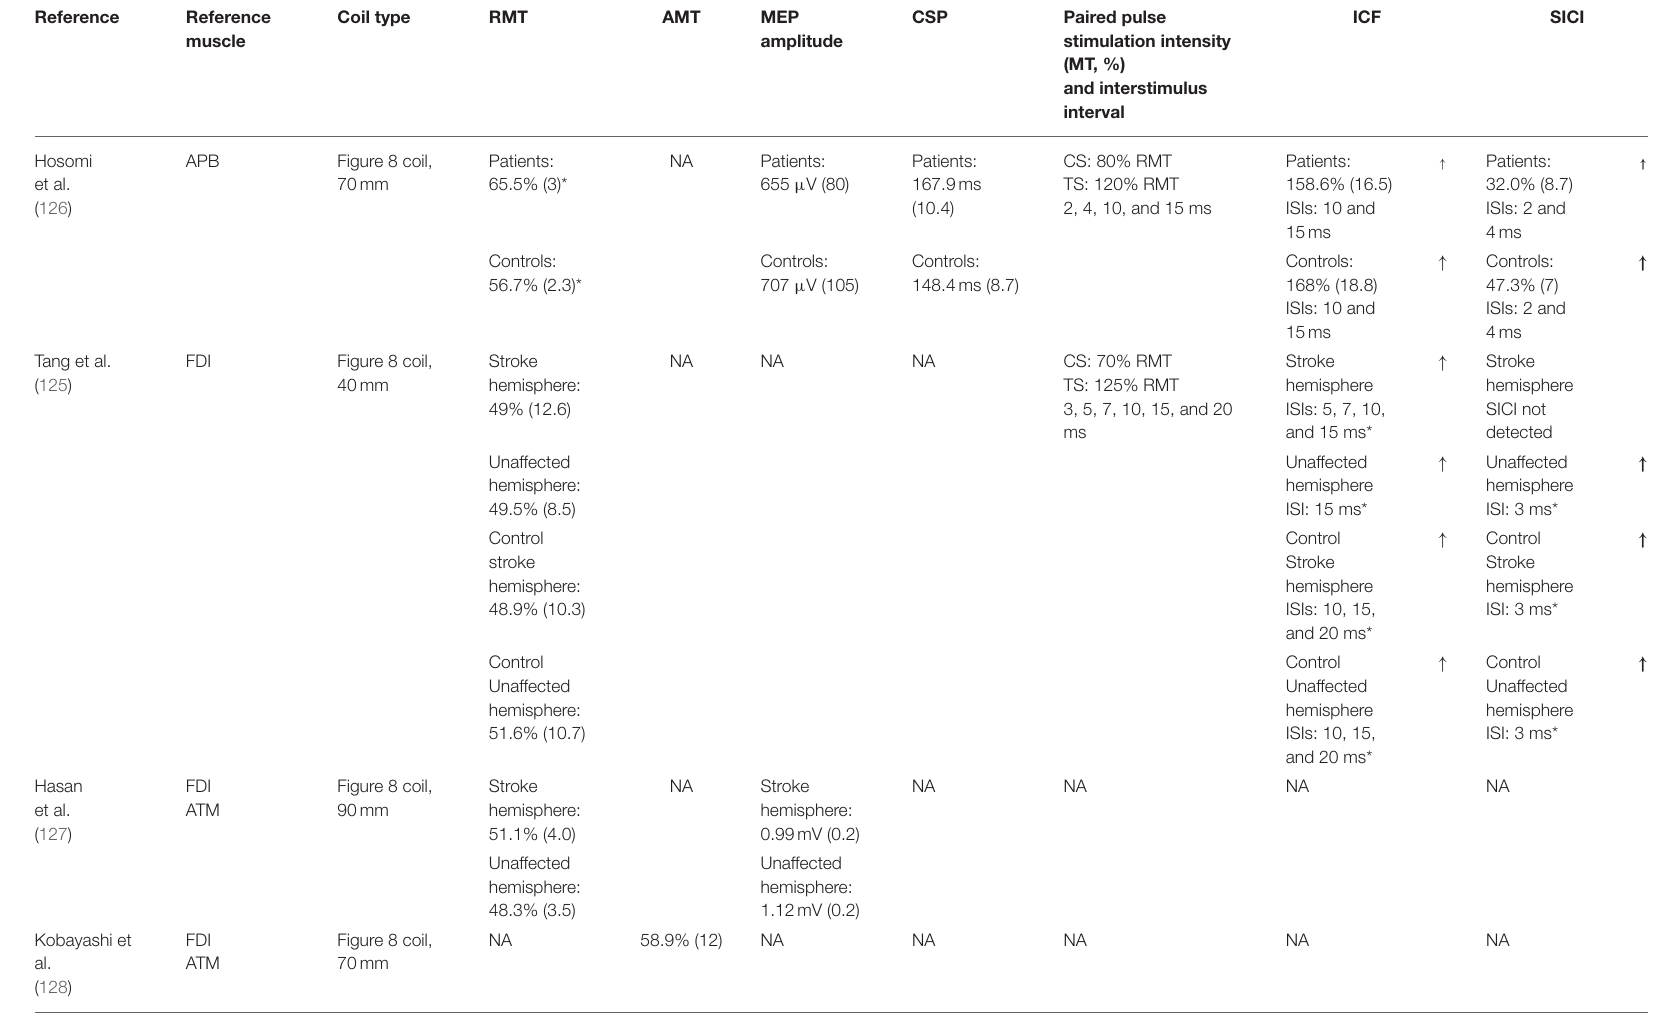
TABLE 3 | Cortical excitability